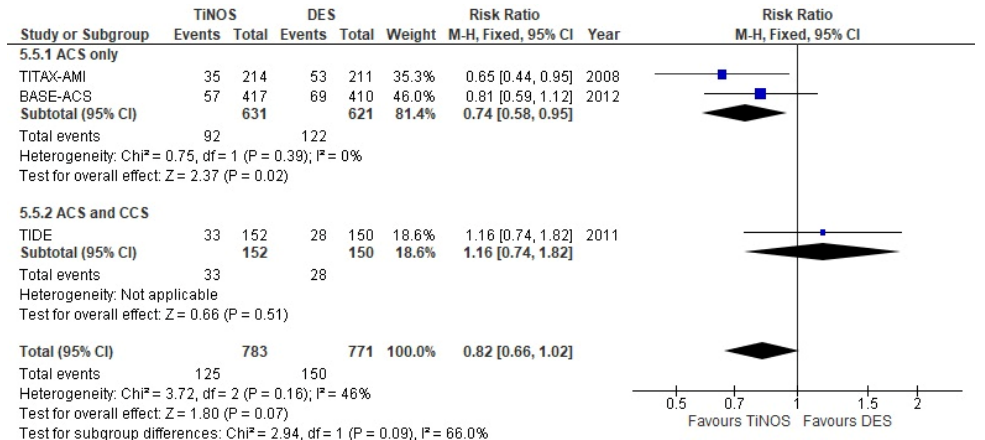
Figure 5. MACE—5 years.